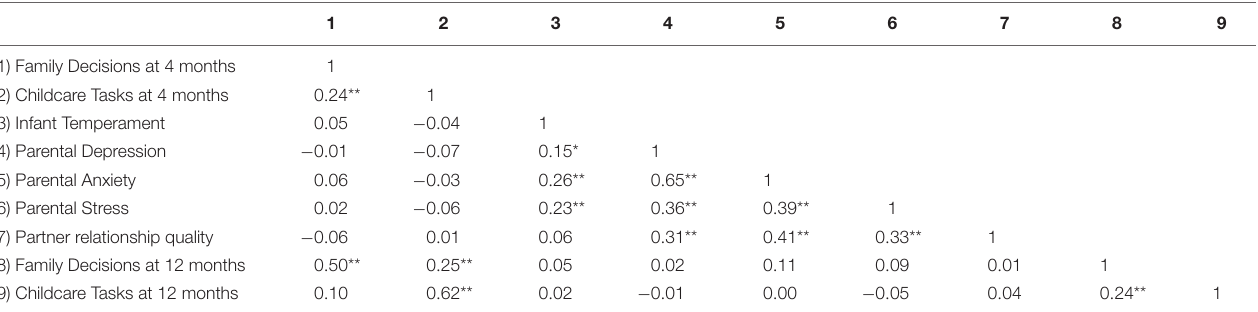
TABLE 3 | Correlations between division of labor, infant temperament, individual parent factors, and interpersonal factors.